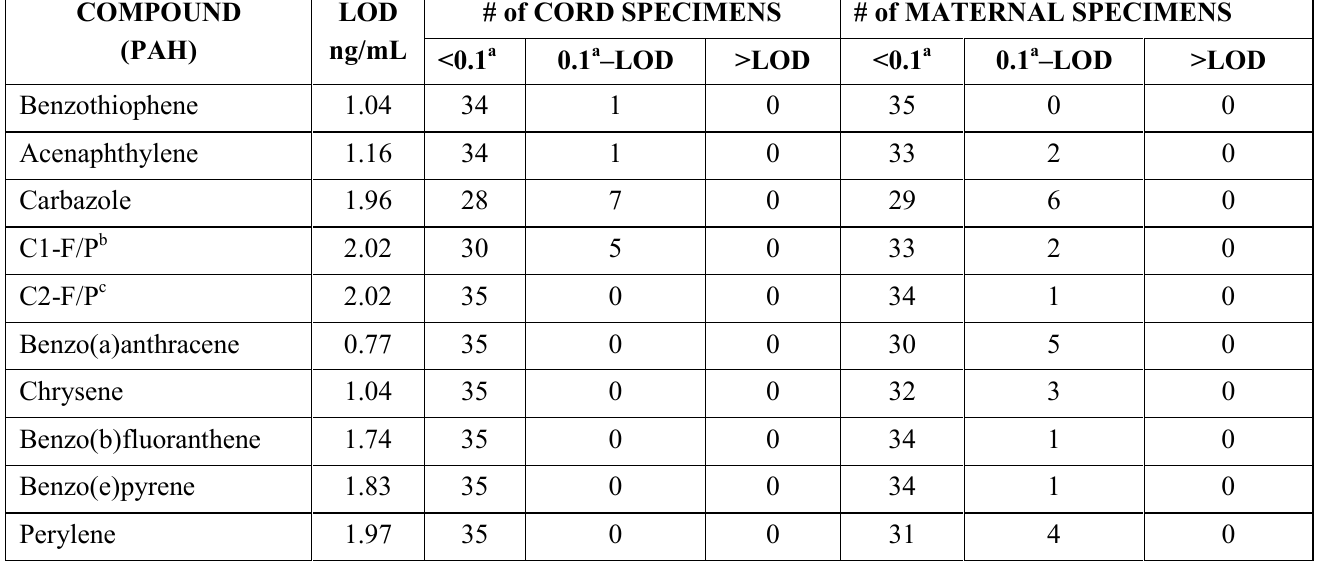
Table A2. Limits of Detection (LOD) and Number of Cord and Maternal Blood Specimens (a) less than 0.1 ng/mL, (b) between 0.1 ng/mL and the Limit of Detection, and (c) greater than the Limit of Detection for 10 Compounds not Measurable in ≥80% to ≤99% of Samples (N = 35 matched sample